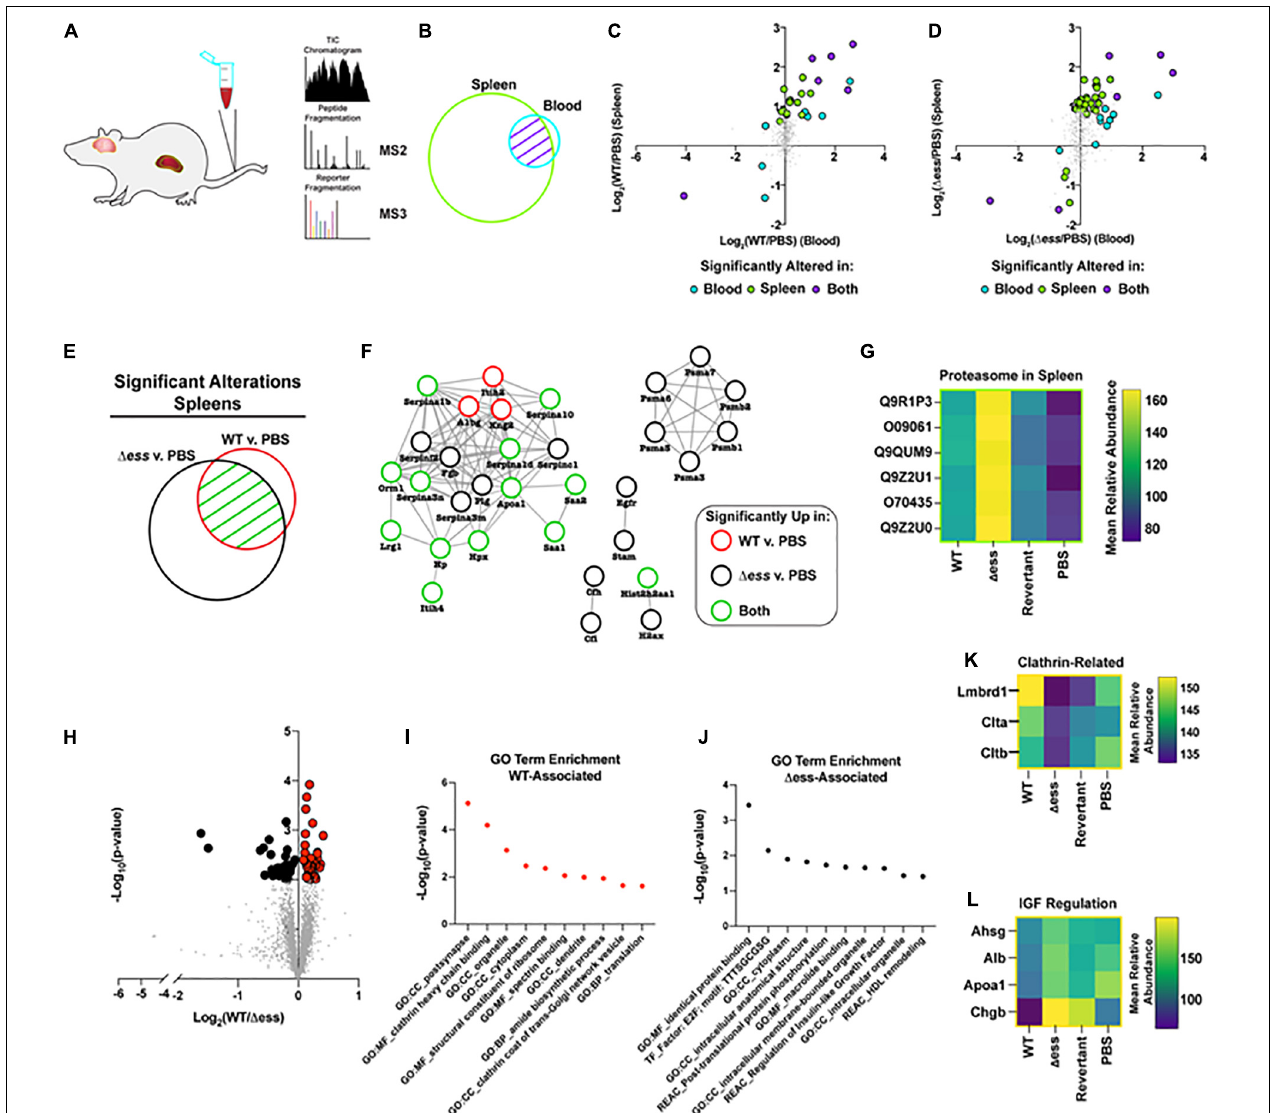
FIGURE 6 | Proteome-based evaluation of S protein-dependent host responses. (A) Schematic of mouse organ proteome experiment. (B) Venn diagram demonstrating overlap in proteins detected and quantified in blood and spleens following proteome analysis. (C) Scatterplot demonstrating Log 2 fold change of WT infected vs. uninfected GBS strains for blood and spleen proteome data. Highlighted datapoints represent significantly altered proteins ( π score > 1.5). (D) Scatterplot demonstrating Log 2 fold change of S protein deletion mutant infected vs. uninfected GBS strains for blood and spleen proteome data. Highlighted datapoints represent significantly altered proteins ( π score > 1.5). (E) Venn diagram demonstrating significantly altered proteins in spleen comparison of WT or S protein deletion mutant strain compared to uninfected. (F) Protein interaction network for the union of significantly altered spleen proteins in comparison of WT or S protein deletion mutant strain vs. uninfected. (G) Heatmap demonstrating proteasome components upregulated in spleens of animals infected with S protein deletion mutant compared to WT GBS infected or uninfected spleens. (H) Volcano plot demonstrating significantly altered ( p < 0.01) proteins in the comparison of brains collected from WT vs. S protein deletion mutant GBS following normalization against uninfected. (I) Non-redundant top enriched functional terms from proteins significantly increased in brains of mice infected with WT GBS compared to the S protein deletion mutant. (J) Non-redundant top enriched functional terms from proteins significantly increased in brains of mice infected with S protein deletion mutant compared to the WT strain. (K) Mean relative abundance heatmap of clathrin-related proteins significantly upregulated in WT GBS infected brains compared to S protein deletion mutant infected brains. (L) Mean relative abundance heatmap of Insulin-like Growth Factor regulation-related proteins significantly upregulated in WT GBS infected brains compared to S protein deletion mutant infected brains.